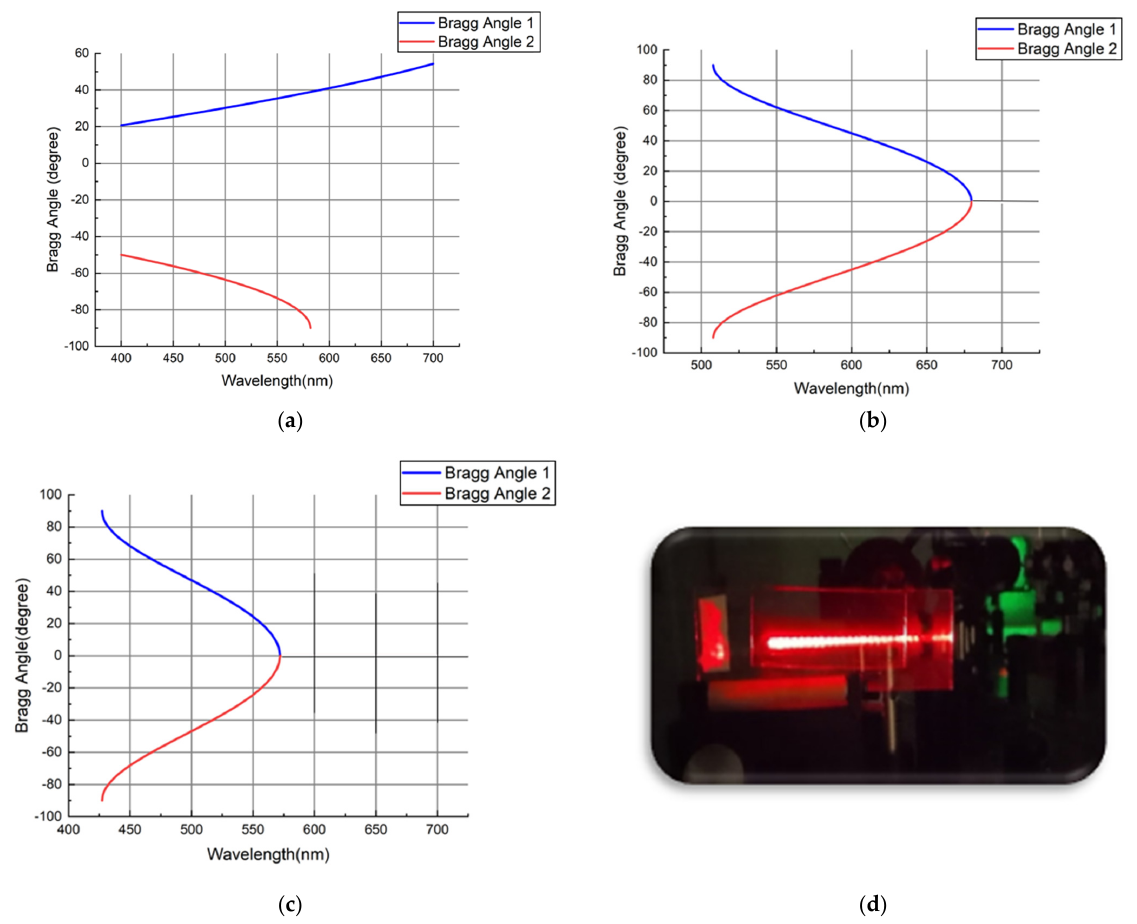
Figure 12. Expected angles for maximum Bragg diffraction vs. wavelength due to ( a ) interference of the reflection of the recording beams with each other, ( b ) interference of recording beam ( − 69.5 ° ) with itself and ( c ) interference of recording beam (33.5 ° ) with itself. ( d ) Photo of 633 nm laser being coupled into a microscope slide via the coupler HOE. Table 3. The expected positions of the spurious peaks (in air) and measured positions of the spurious peaks (in air) for all three different wavelengths. Not Applicable (NA) means angles are imaginary in